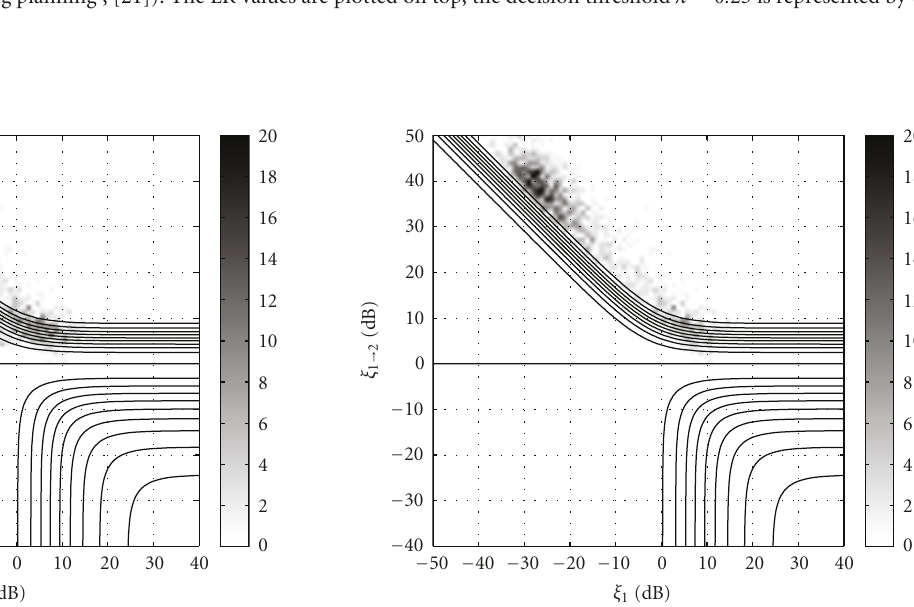
Figure 12: Occurrences of phoneme “t” in sentences disturbed at 10dB mean segmental SNR.